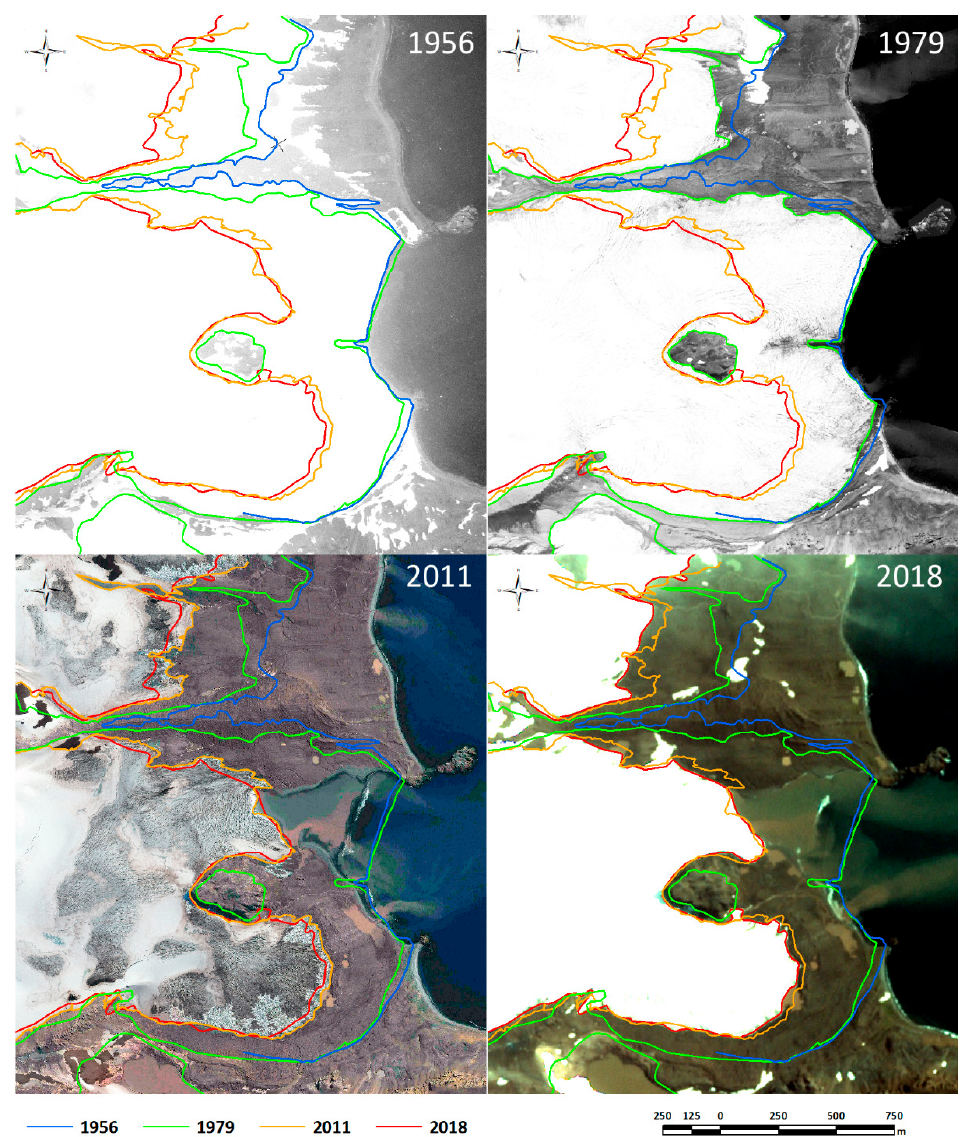
Figure 4 . The Baranowski Glacier (tidewater glacier) and Sphinx Glacier—part Sb (land-terminating glacier). The comparison of the PlanetScope satellite image (2018) with BAS (1956), Polish aerial photos (1979), and Geo-Eye1 (2011).